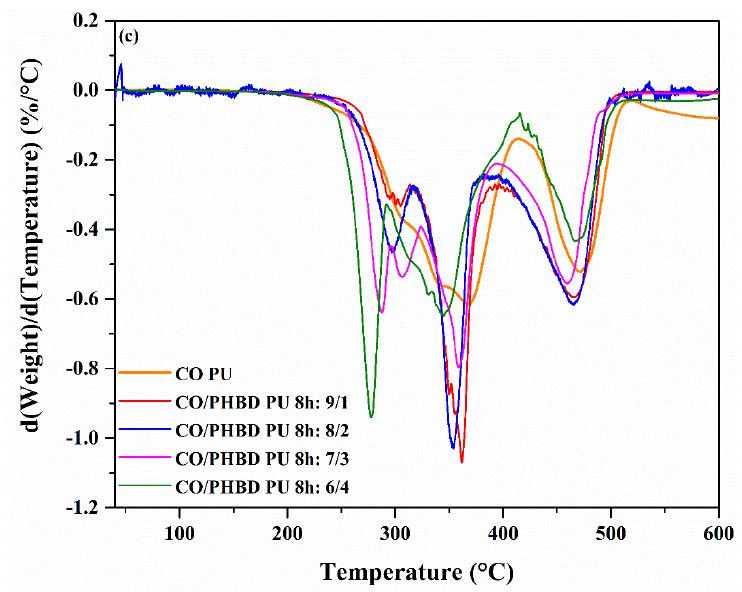
Figure 6. ( a ) DSC, ( b ) TGA, and ( c ) derivative TGA curves of CO/PHBD PU 8h. Table 2. Crystallinity, melting enthalpy, and TGA data of CO/PHBD PU 8h.